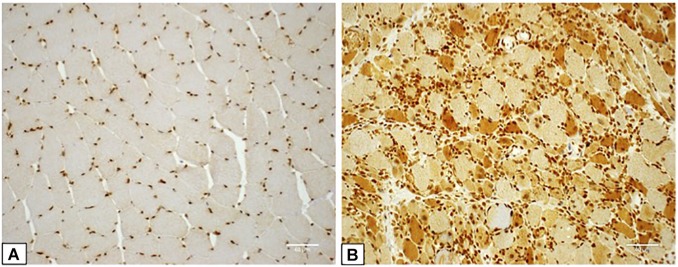
Staining for High Mobility Group Box Protein 1 (HMGB1) in control and IIM muscle. (A) Muscle tissue from a control subject demonstrating lightly stippled sarcoplasmic HMGB1 staining and strong positive staining of muscle nuclei. This case was assigned HMGB1 grade zero. (B) Muscle tissue from a patient with seronegative MHC I + NM demonstrating positive staining of numerous muscle fibers, muscle cell nuclei and inflammatory cells. This case was assigned HMGB1 grade 3. Magnification: x 200. IIM, idiopathic inflammatory myopathy; IMNM, immune-mediated necrotising myopathy; MHC I, major histocompatibility complex I.